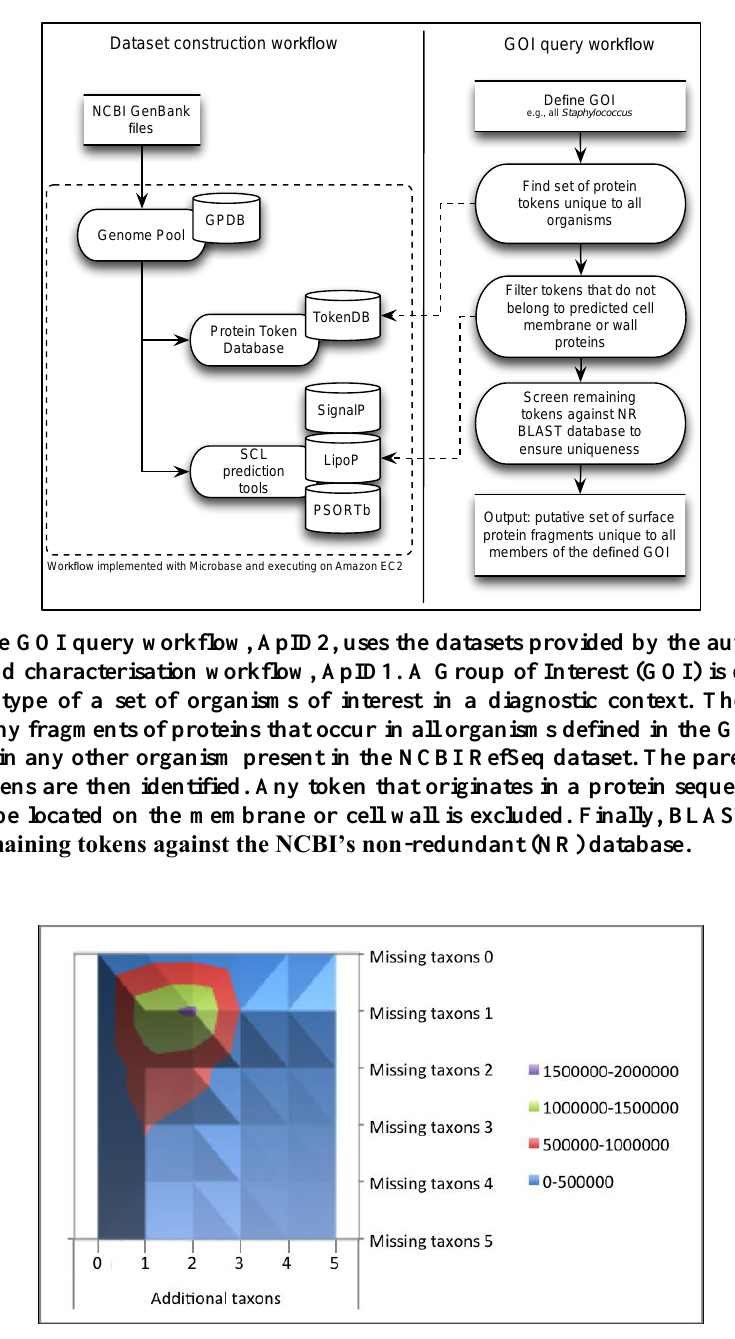
Figure 4: A heatmap showing the distribution of tokens around a Group of Interest. Each cell contains a count of unique diagnostic token strings found by adding or removing organisms from the initial GOI. In this figure, a peak can be seen when 2 extra organisms are added and one of the existing organisms is removed from the original GOI definition. Such a huge increase in tokens may indicate that the original GOI was incorrect, especially if most of the additional tokens found at 2, 1 are from the same two additional